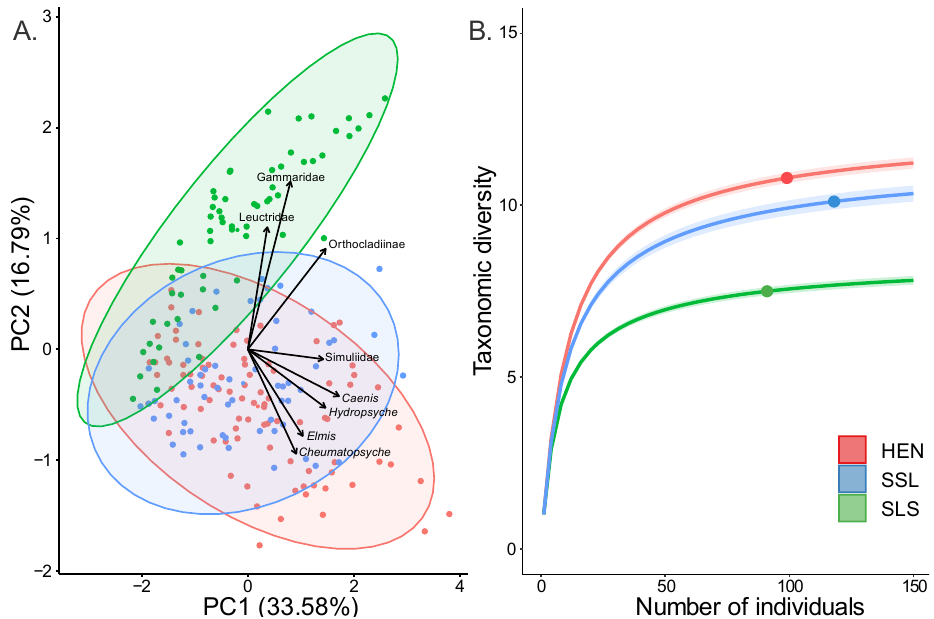
Figure 2. The macroinvertebrate community. ( A ) Principal component analysis (PCA) biplot per- formed on macroinvertebrate abundances (log 10 (x + 1) transformed). ( B ) Taxonomic diversity ( 1 D) and 95% CIs (shaded area) of the macroinvertebrate community. Dots indicate the estimate of taxonomic diversity standardised at 95% sample coverage. Table 3. Summary of trophic niche traits for Z. asper and C. gobio and of the diversity ( 1 D) and density (inv.m −2 ) of the macroinvertebrate community.